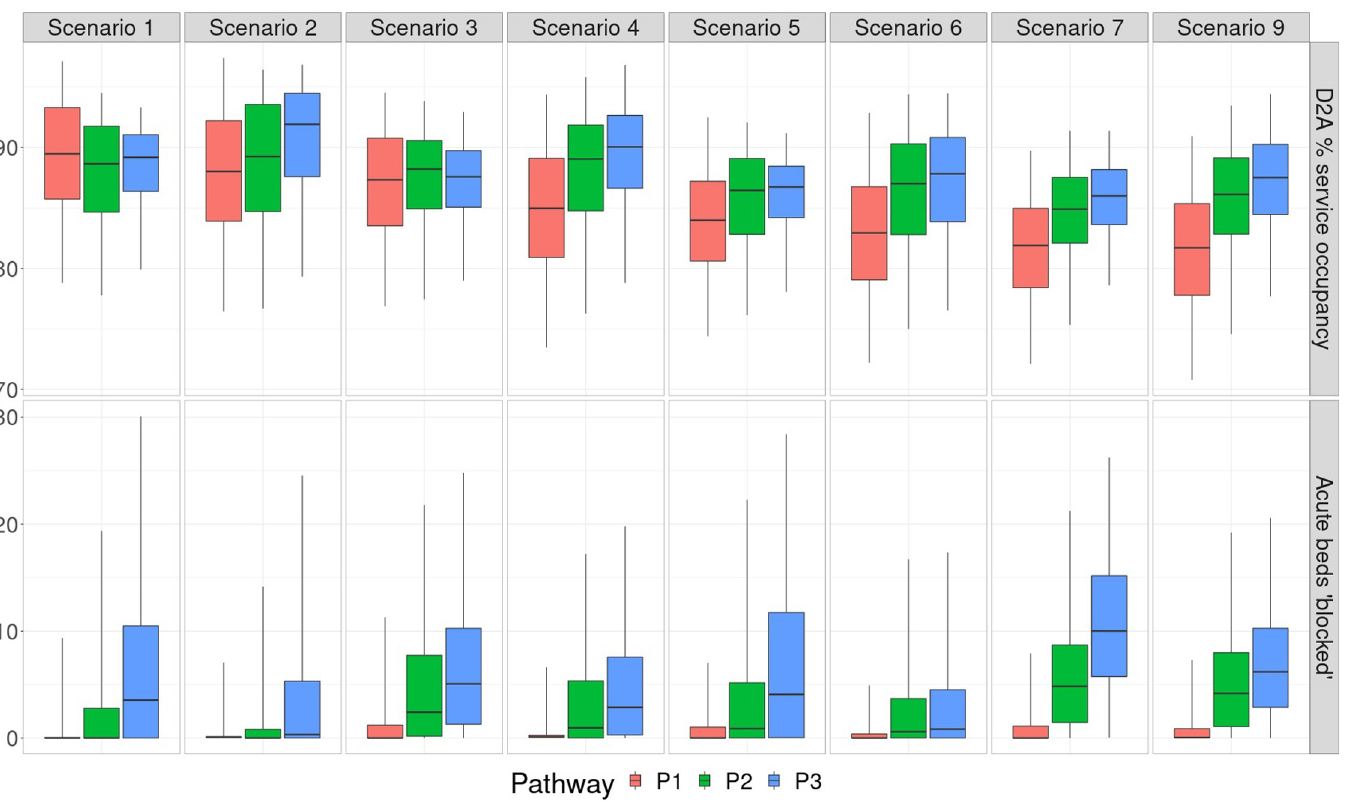
Fig 4. Box-whisker plots illustrating, for the cost-optimal D2A capacities, the median and interquartile range of D2A service occupancy (expressed as a proportion of total capacity) and number of acute beds blocked.